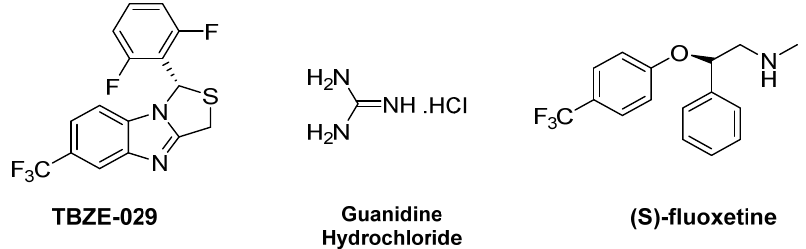
Figure 10. Chemical structure of TBZE ‐ 029, GuaHCl and (S) ‐ fluoxetine. Commercial drug phenotypic screening is a growing trend for the discovery of novel antivirals. The repositioning of marketed drugs, which have already passed clinical trials, can guarantee their safety and allow for time and money ‐ saving [37–41]. A molecular screening of a National Institutes of Health (NIH) chemical library against EVs identified fluoxetine (Figure 10), an FDA approved drug, for the treatment of major depression and anxiety disorders [42]. Further studies showed that the EC 50 of fluoxetine against CV ‐ B3 is 3.36 μ M and mode ‐ of ‐ action studies have shed light on the role of the chirality for the activity. While the racemic mixture showed an EC 50 of 3.2 μ M, the (S) ‐ enantiomer proved to be more active with an EC 50 of 0.4 μ M; surprisingly, the (R) ‐ enantiomer did not show any effect against CV ‐ B3. Through a homology model of 2C from CV ‐ B3, the authors pre ‐ dicted that the 4 ‐ (trifluoromethyl)phenyl ring of (S) ‐ fluoxetine lies in the deep hydropho ‐ bic pocket close to residues L126, L178, V187, F190, L238, I227, A229, and F242 [34]. Hurdiss et al. investigated its mode of action by generating the crystal structure of the soluble fragment of CV ‐ B3 2C in complex with fluoxetine. Cryo ‐ electron microscopy anal ‐ ysis demonstrated that fluoxetine binds the 2C protein in an exameric, stabilized state which results in an “open conformation” which could not assist the replication process. Since this conformational state of 2C implies that the protein cannot express ATPase ac ‐ tivity, fluoxetine can be considered a 2C ATPase dose ‐ dependent inhibitor. [35]. Since this data supported the potential use of fluoxetine as an antiviral, several re ‐ search groups have synthesized fluoxetine analogues in the search for more potent com ‐ pounds. Manganaro et al. investigated the importance of the p –CF 3 substituent by moving it to the ortho or meta positions, or by introducing a second substituent [43]. The authors also designed fluoxetine analogues, replacing the methylamine group with the pan ‐ enter ‐ ovirus inhibitor GuaHCl or an acetyl group, to explore the need of a basic nitrogen. While moving the ‐ CF 3 substituent or introducing a second one on the ring proved detrimental, changes on the amino motif, especially the introduction of a guanidine group, retained antiviral activities (compounds 19 and 20 , Figure 11). Further studies on the (R) and (S) enantiomers of compound 18 confirmed the importance of the stereochemistry. As with fluoxetine, the ( S ) enantiomer showed improved antiviral activity (EC 50 = 0.19 μ M) com ‐ pared to both the ( R ) enantiomer (EC 50 = >30 μ M) and the racemic mixture of 20 (EC 50 = 0.41 μ M) [43].